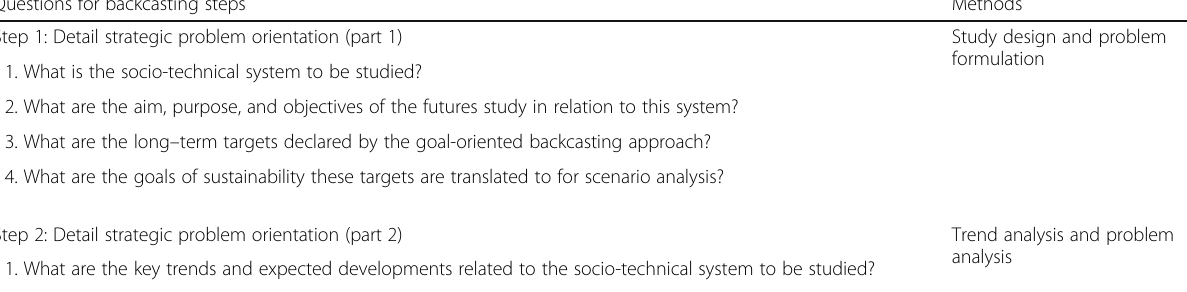
Table 1 The guiding questions for each step in the backcasting study Questions for backcasting